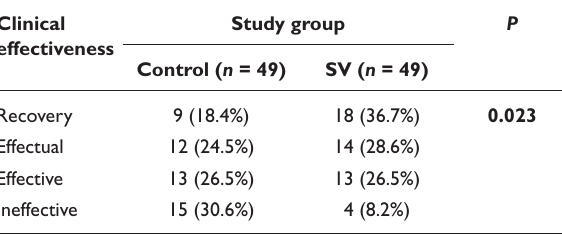
Table 2. Comparison of clinical effectiveness in the treatment of